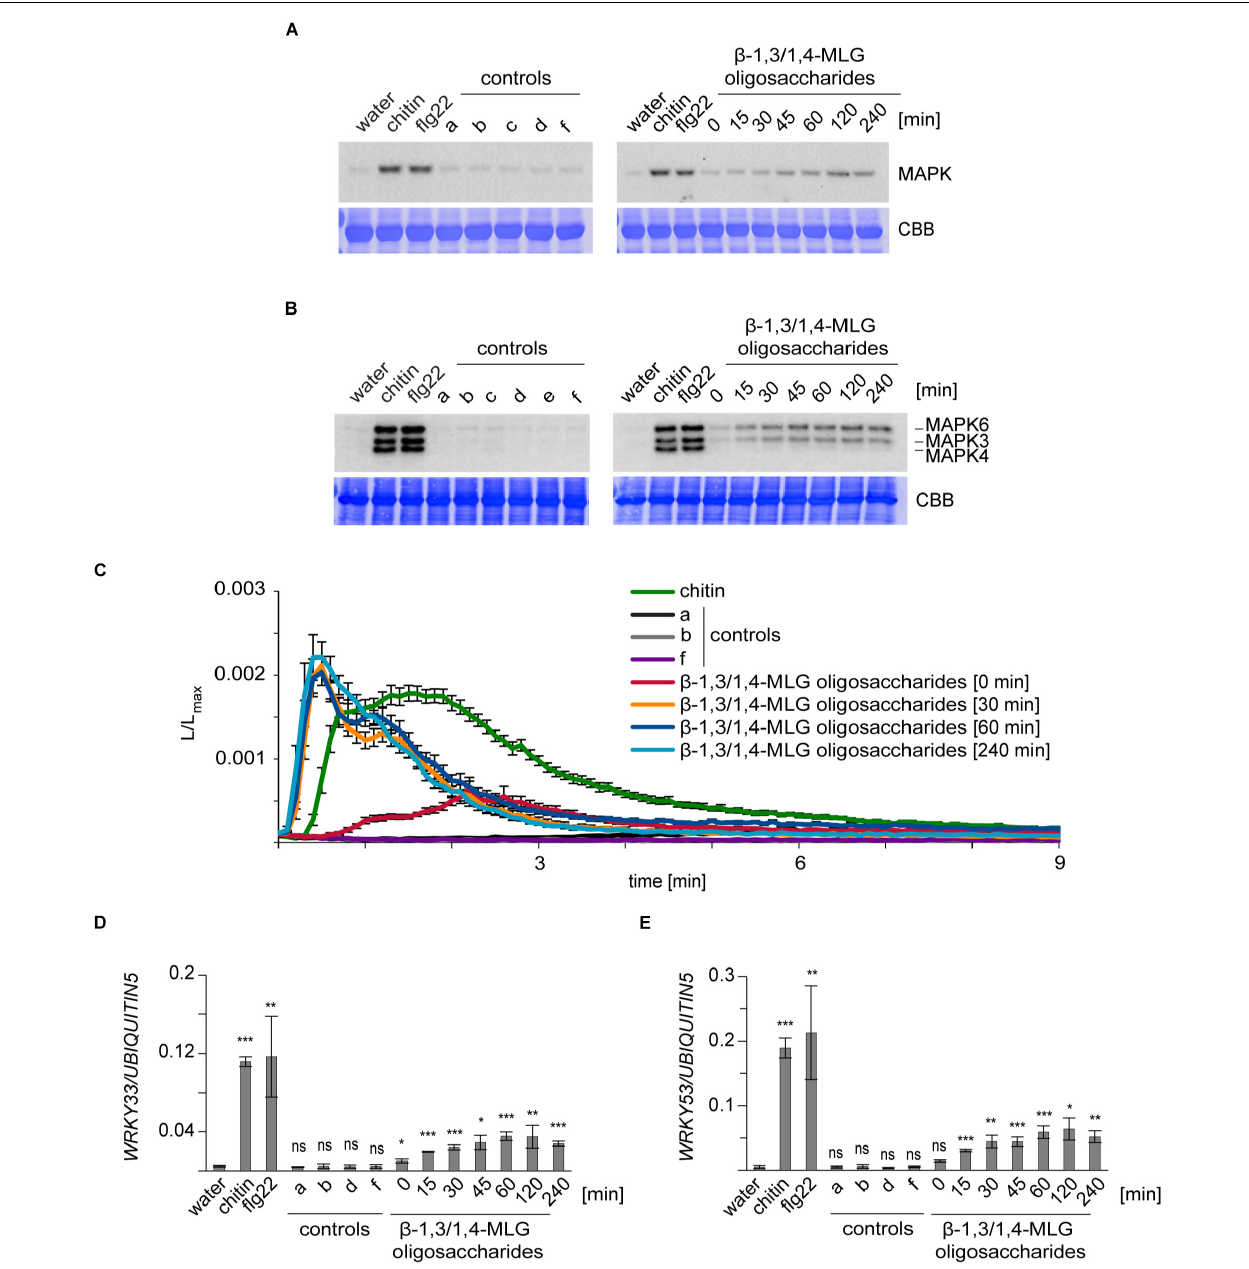
FIGURE 1 | Enzymatically-generated β -1,3/1,4-MLG oligosaccharides induce immune responses in A. thaliana and H. vulgare . β -1,3/1,4-MLG oligosaccharides were generated by incubation of the β -1,3/1,4-MLG polysaccharide (10 mg ml − 1 ) with the B. subtilis lichenase (0.025 U/ml) and was stopped at several time points (0, 15, 30, 45, 60, 120, or 240 min). For the treatment, a 1:10 dilution of the hydrolysis products was used. Chitin (10 µ g ml − 1 for MAPK activation and defense gene expression; 100 µ g ml − 1 for calcium elevation) and flg22 (50 nM) served as positive controls. As negative controls, water, sodium phosphate buffer (a, 10 mM), β -1,3/1,4-MLG polysaccharide (b, 1 mg ml − 1 ), active lichenase (c, 0.0025 U ml − 1 ), heat-inactivated lichenase (d, 0.0025 U ml − 1 ; e, 0.00125 U ml − 1 ) and β -1,3/1,4-MLG polysaccharide (1 mg ml − 1 ) and heat-inactivated lichenase (f, 0.0025 U ml − 1 ) were used. (A,B) : MAPK phosphorylation in (A) leaf discs of 12–14 day-old H. vulgare plants and (B) 14-day-old Arabidopsis Col-0 seedlings upon elicitation with β -1,3/1,4-MLG oligosaccharides. As loading control, the PVDF membrane was stained with Coomassie Brilliant Blue (CBB). The data shown are derived from one of three biological replicates that gave similar results. (C) Calcium elevation in 8–10 day-old Arabidopsis Col-0 aequorin lines in response to enzymatically generated β -1,3/1,4-MLG oligosaccharides. The luminescence was assessed immediately after elicitor treatment (L) and was normalized to total luminescence measured upon addition of calcium (L max ). The data show mean of twelve seedlings with SEM from one of three biological experiments that produced similar results. (D,E) : Expression of the defense genes WRKY33 (D) and WRKY53 (E) in 14-day-old Arabidopsis Col-0 seedlings upon treatment with enzymatically generated β -1,3/1,4-MLG oligosaccharides. Data are presented as means of three biological replicates (with three technical replicates each) ± SD. UBIQUITIN5 was used as reference gene. Statistical significance (unpaired student’s t -test) of elicitor treatment compared to water treatment: ns = p > 0.5; * = p ≤ 0.5, ** = p ≤ 0.05, *** = p ≤ 0.001.